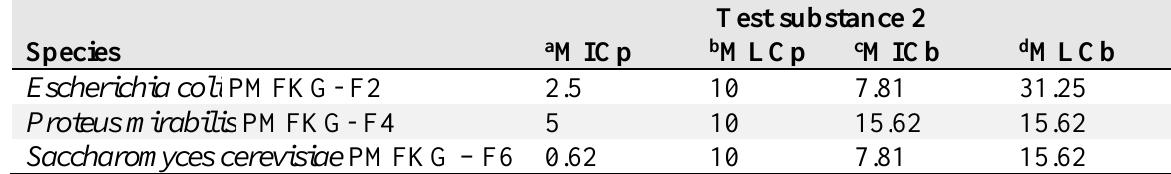
Table 5. Resistance of planktonic cells and biofilms in the presence of test substance 2.